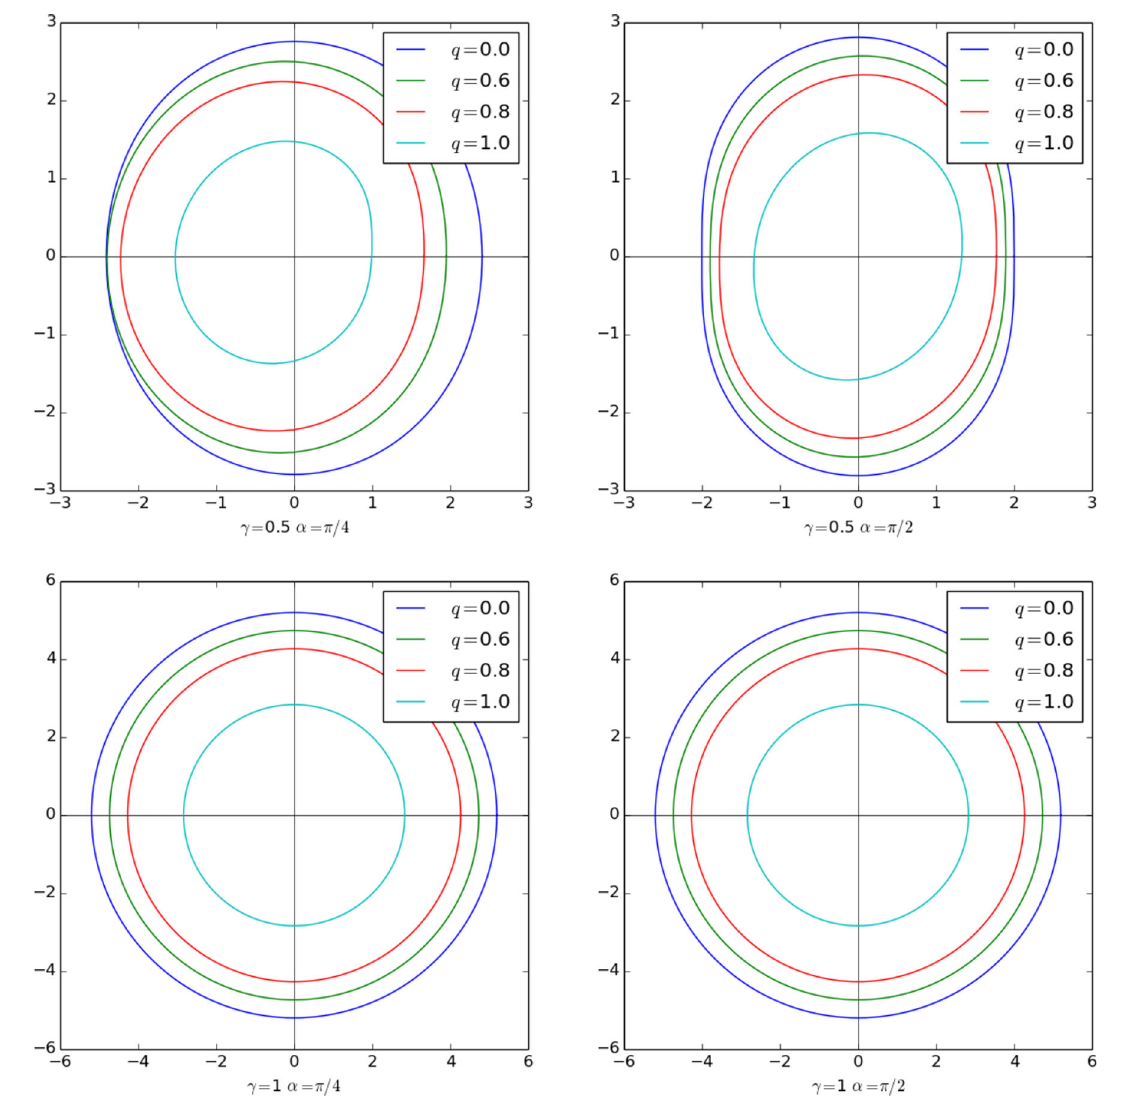
againthat q mustnotbeinterpretedasarotationparameterbutisinstead related to the NUT charge. On the other hand, departures from the NUT case, i.e. γ (cid:5)= 1 significantly alter the shape of the shadow, as